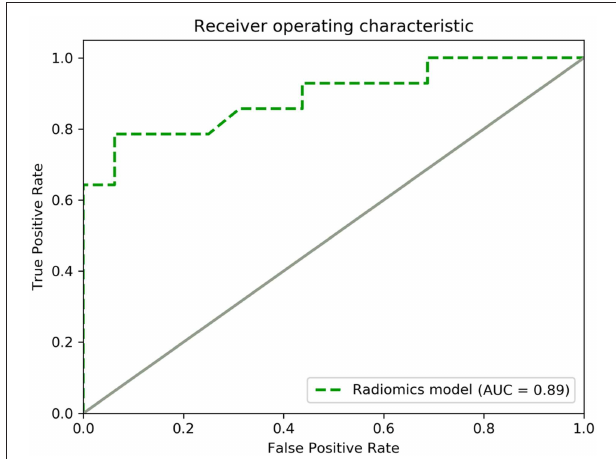
FIGURE 8 | ROC curve for the performance of the radiomics model in the multicenter prospective validation.